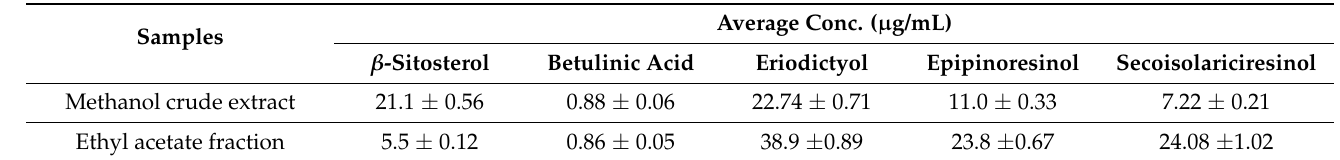
Table 3. Determination of β -sitosterol, betulinic acid, eriodictyol, epipinoresinol, and secoisolari- ciresinol in herbal extracts using the proposed GC-MS